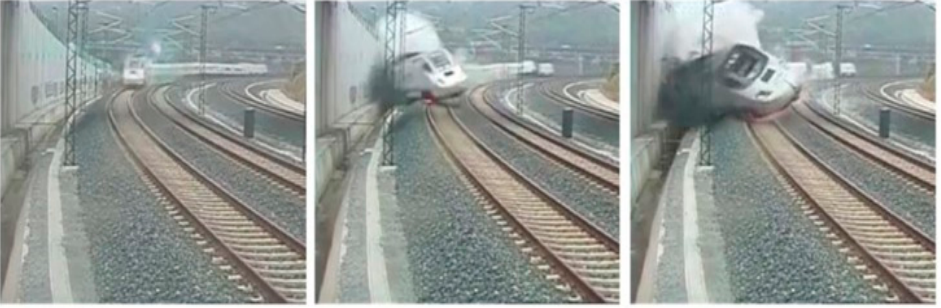
Figure 1. Derailment accident in Spain.